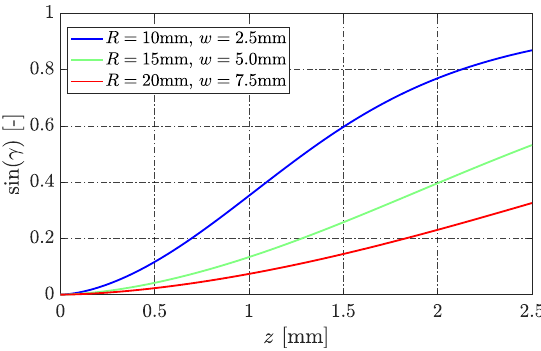
Figure 4: Scaling factor for F s when Q is positive.